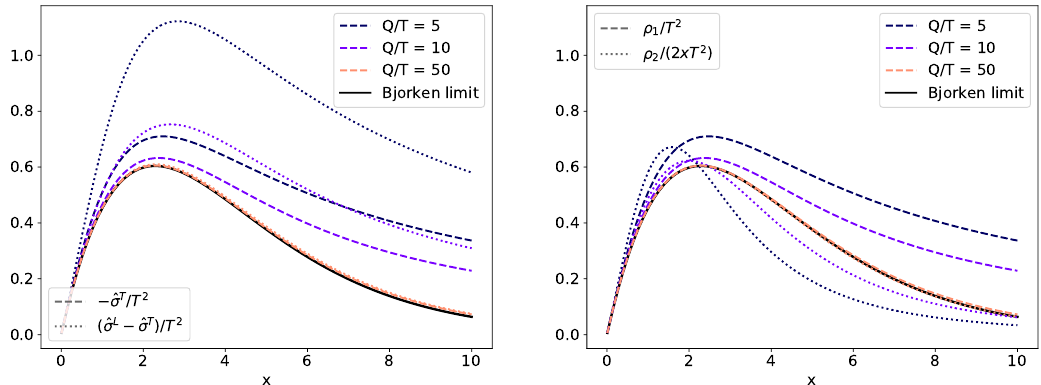
Figure 3 . Left: approach to the Bjorken limit of the transverse as well as transverse-minus- longitudinal spectral function, in the case of a plasma of free fermions. The free spectral functions from [21] have been used. Right: breaking of the Callan-Gross relation ρ 2 = 2 xρ 1 at finite Q 2 in the free theory. The functions ρ 1 and ρ 2 have been computed from the free spectral functions using eq. (4.1). In both panels, N c = 3 and P Q 2 = 1 has been chosen. f f